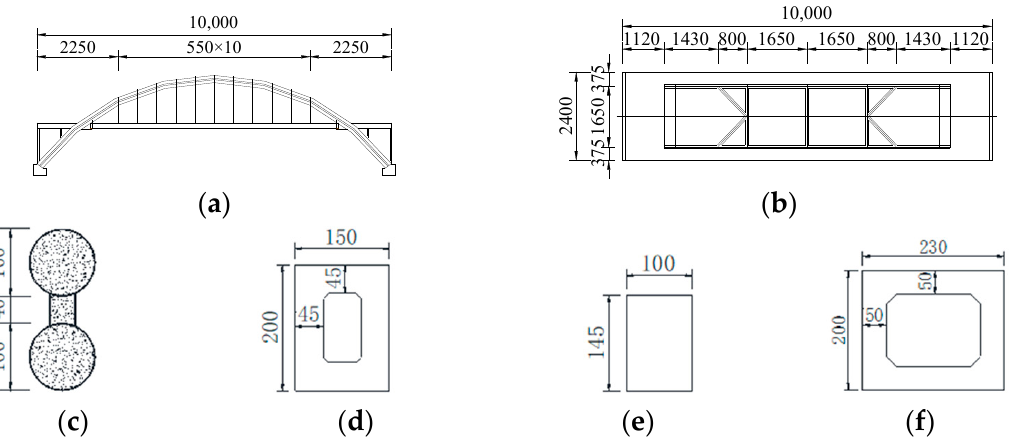
Figure 18. The general layout and main component cross-sections of a 100 m half-through CFST standard arch bridge (unit: cm): ( a ) elevation; ( b ) plan; ( c ) arch rib; ( d ) longitudinal beam; ( e ) central crossbeam; ( f ) end beam.